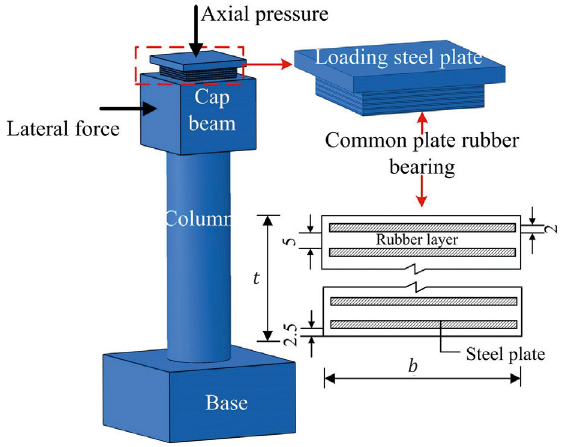
Figure 1. Finite-element model of the series